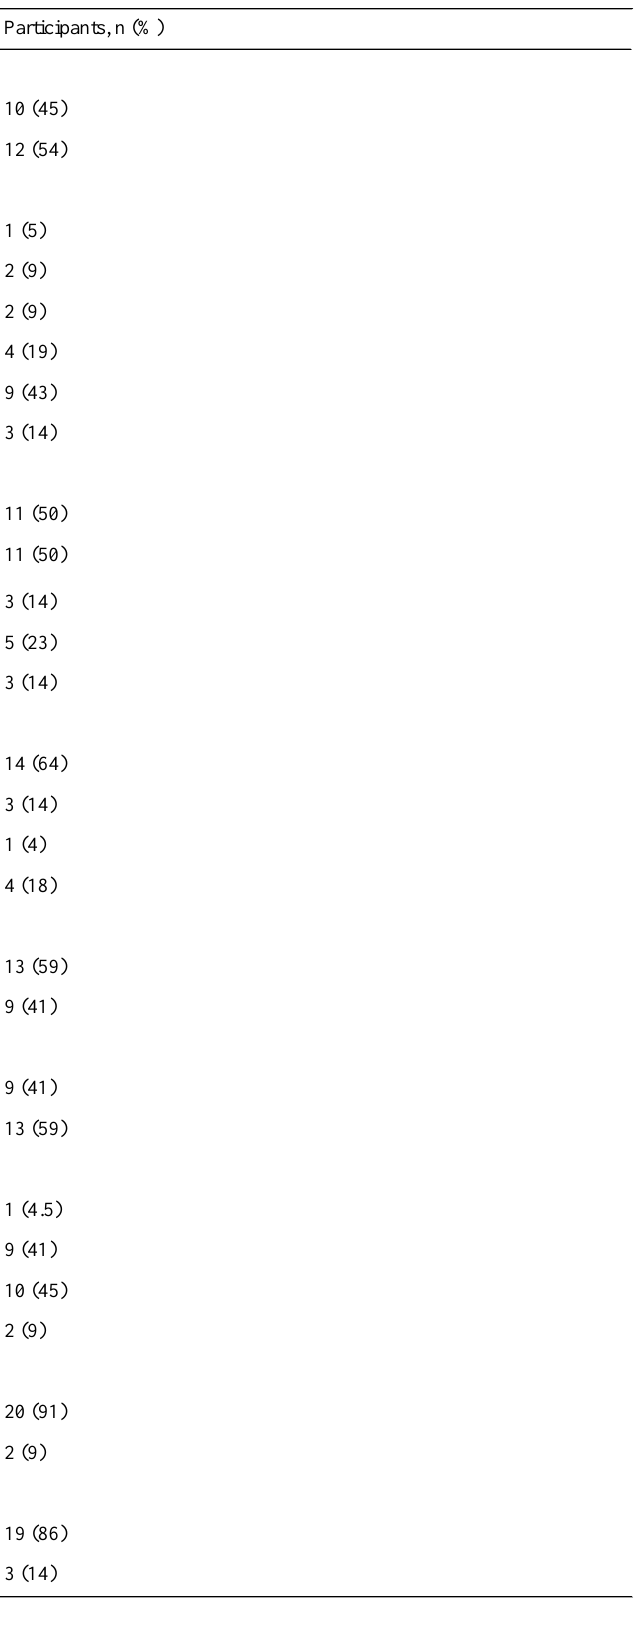
Table 1. Participant characteristics